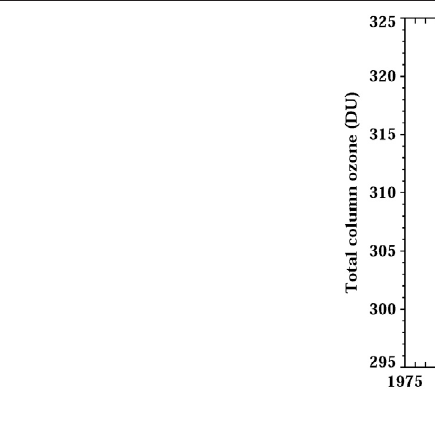
Frontiers in Earth Science |